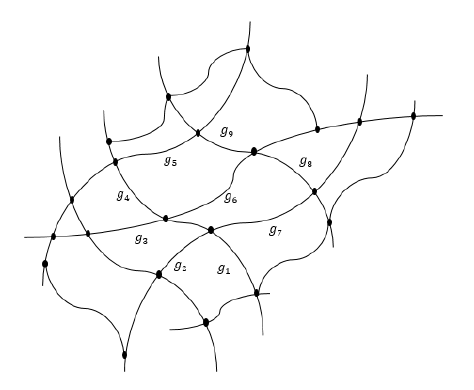
Figure 1. A diagram of spin network. See text for